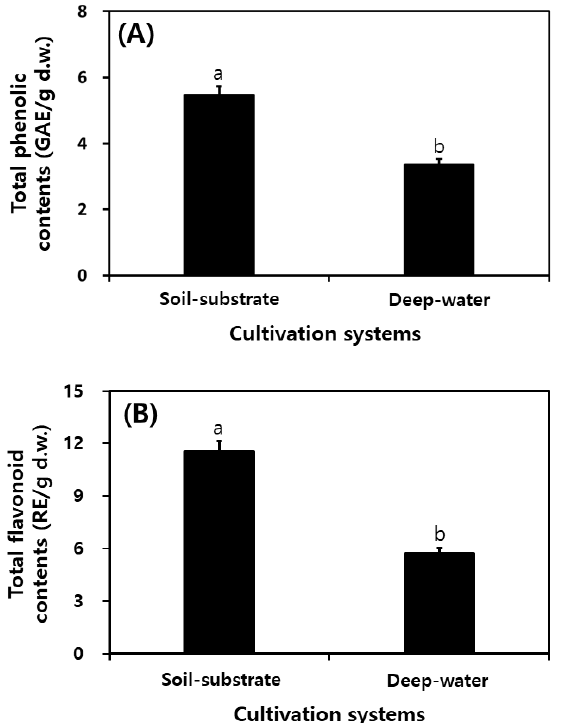
Figure 2. Comparison of total phenolic and total flavonoid contents of PGS in different cultivation systems in a plant factory. ( A ) Total phenolic contents; ( B ) total flavonoid contents. All values are presented as the mean ± SD of pentaplicate determination. Different letters correspond to the significant differences related to the processing steps using Tukey’s multiple test ( p < 0.05).